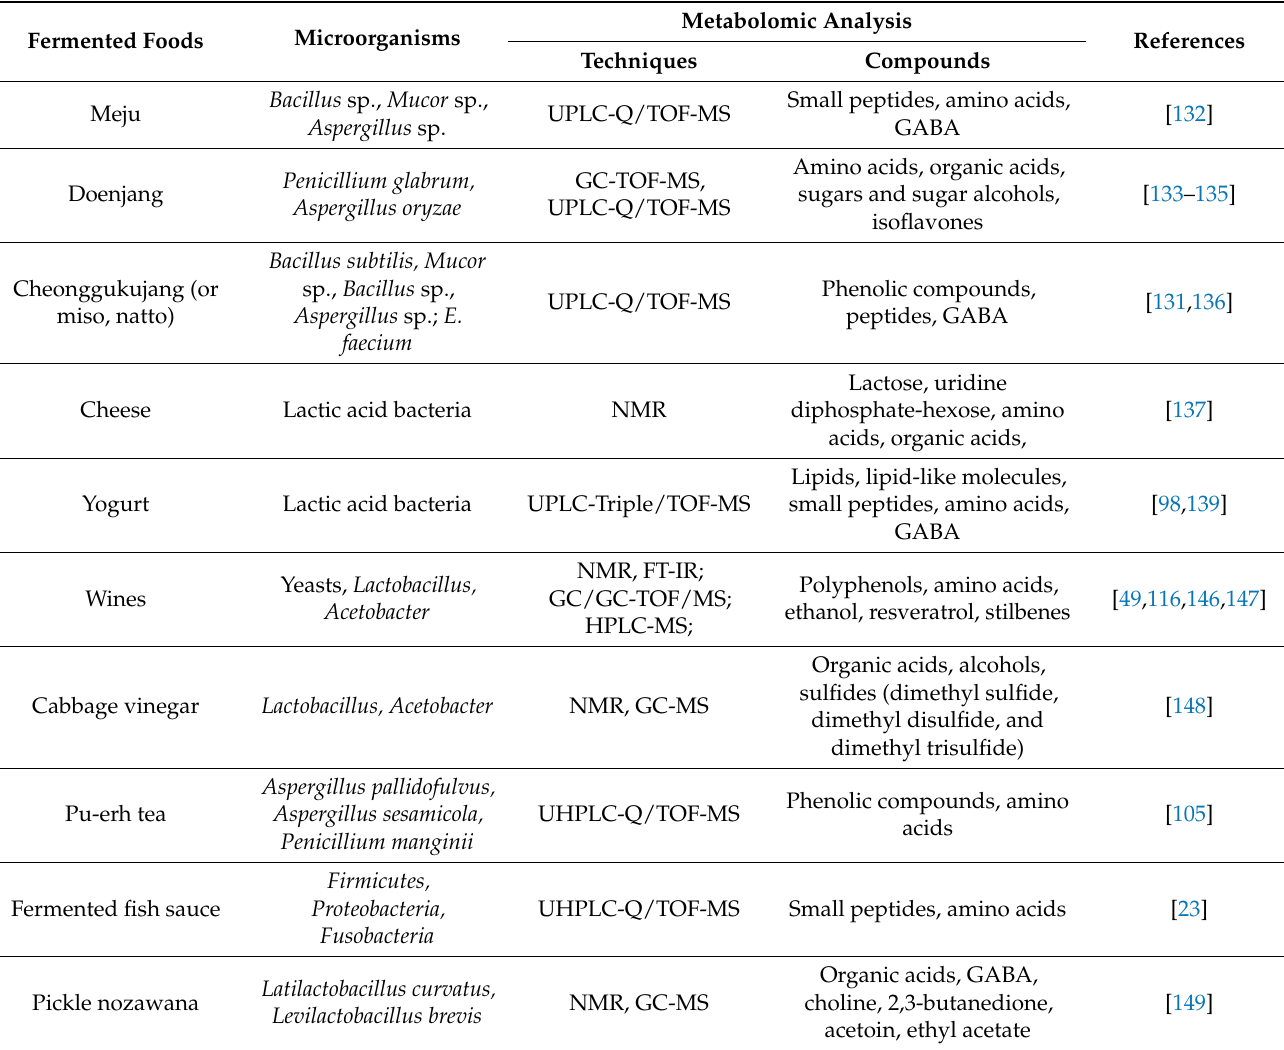
Table 3. Metabolomic analysis techniques applied to different fermented foods considering nutritional and functional